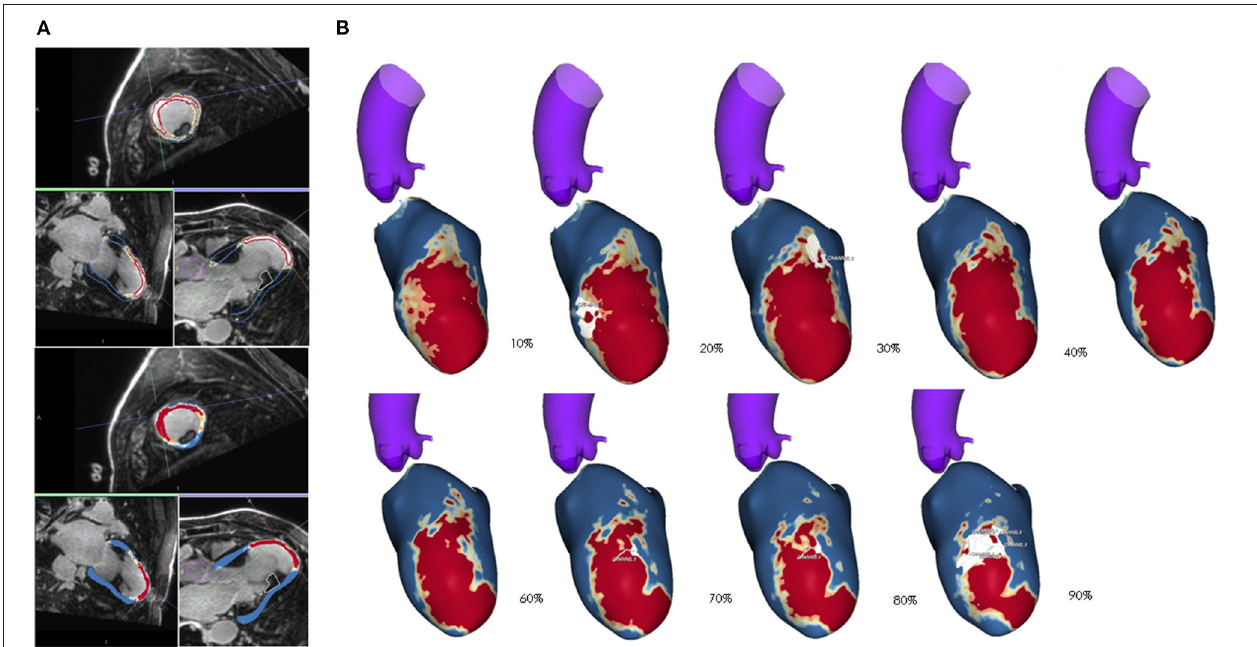
FIGURE 1 | (A) Raw images of cardiac magnetic resonance (CMR) in a patient with chronic anterior myocardial infarction. The bright area seen is due to late gadolinium enhancement (LGE). Automatic segmentation of endocardium and epicardium with detection of the core scar is shown in red (intensity of LGE > 60% of the area with maxim intensity signal of LGE), healthy tissue is shown in blue (intensity of LGE < 40% of the area with maxim intensity signal of LGE) and the border zone is shown in yellow (areas with intermediate LGE intensity). (B) Three-dimensional reconstruction of CMR is shown from endocardium (layer 10%) to epicardium (layer 90%) with large anterior transmural myocardial infarction, with area of channels (white) of intermediate tissue (yellow) crossing the core scar